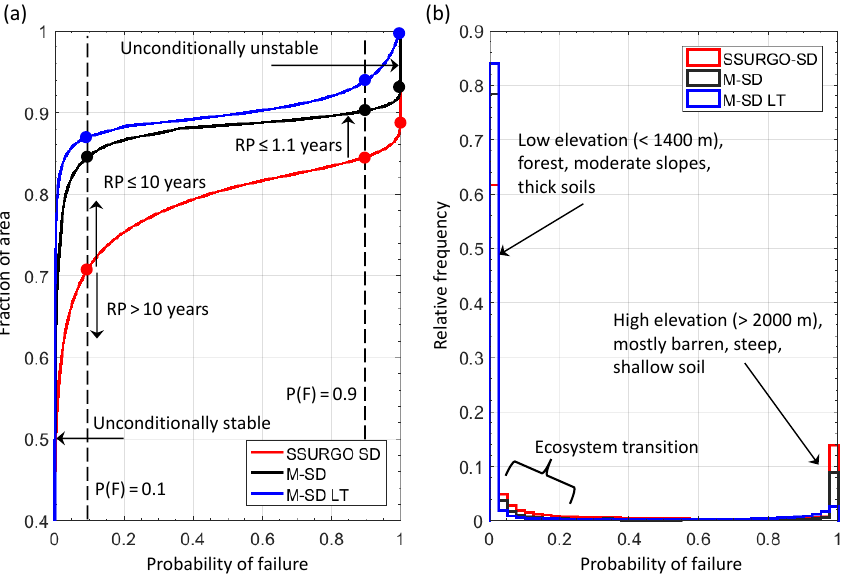
Figure 10. (a) Cumulative distribution and (b) relative frequency of P ( F ) (bin size (cid:49)P ( F ) = 0.025) mapped over NOCA from Landlab simulations using SSURGO-SD and two M-SD scenarios. Labels indicate dominant controls on the distribution of P ( F ) in (b) . The fraction of area is used for cumulative spatial probability, plotted using the Weibull plotting position. Return periods for landslides are illustrated only for